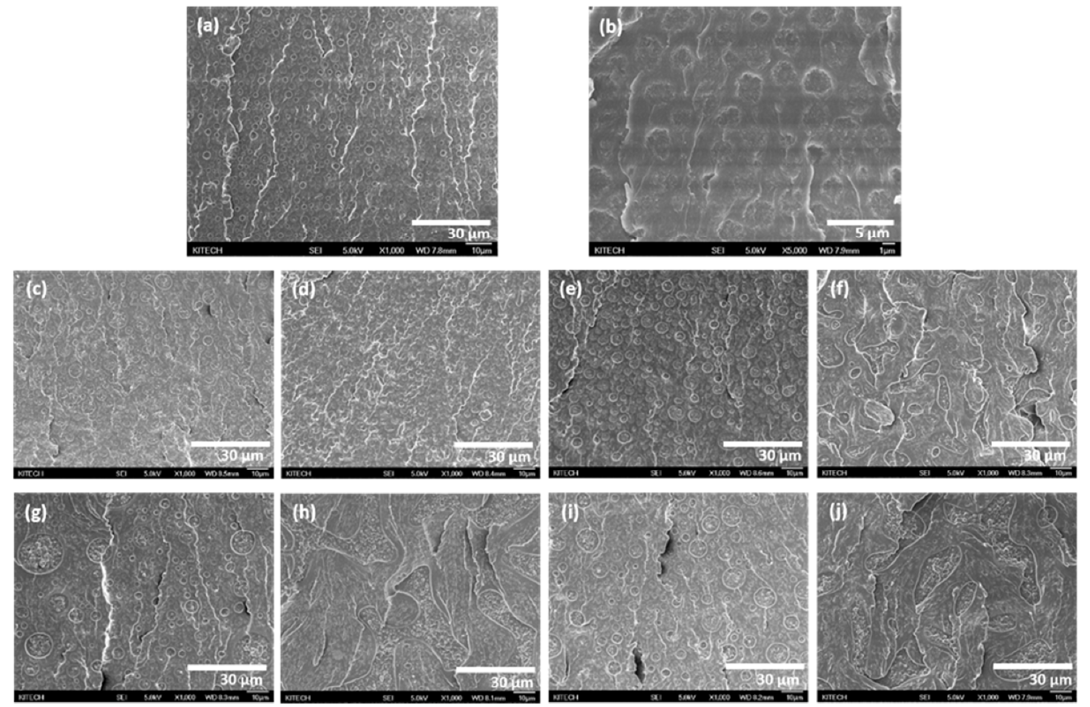
Figure 6. Scanning electron microscopy (SEM) images of the fracture surface of silica-modified epoxy adhesives by DMA specimens (1000× magnification except ( b )): ( a ) control; ( b ) control (5000× magnification); ( c ) 0.1 vol% FS-PDMS; ( d ) 0.4 vol% FS-PDMS; ( e ) 0.1 vol% FS-OH; ( f ) 0.4 vol% FS-OH; ( g ) 0.1 vol% FS-EP; ( h ) 0.4 vol% FS-EP ( i ) 0.1 vol% FS-NH; ( j ) 0.4 vol% FS-NH.